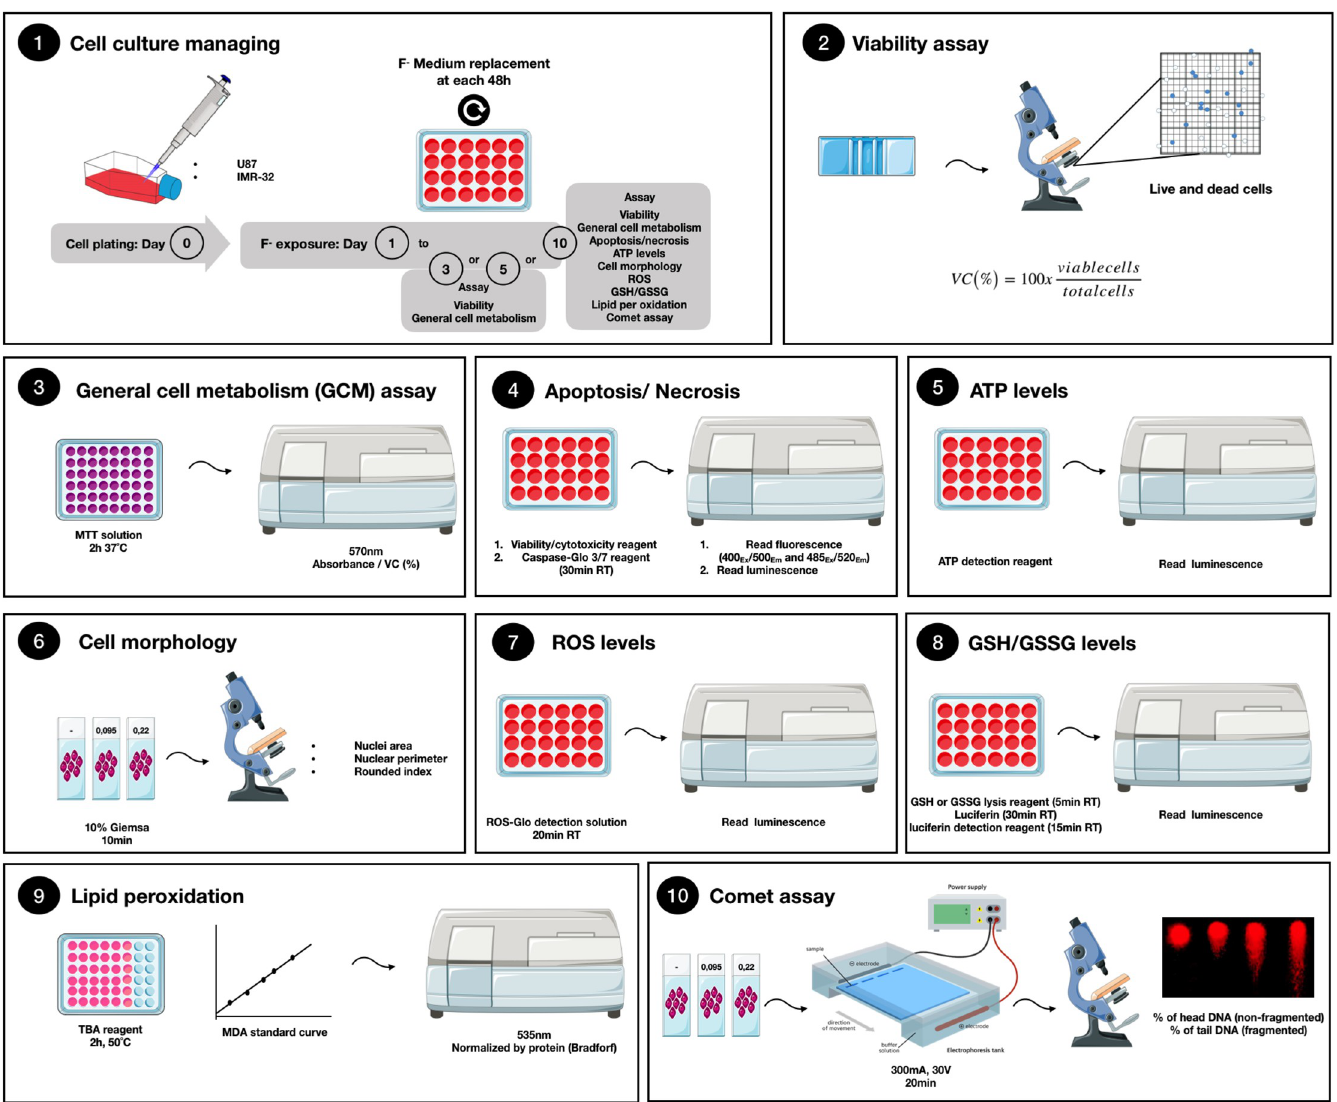
Fig 1. Methodological framework of cell culture and analyses. 1) U87 and IMR-32 cells were maintained in DMEM+10%FBS. Cells were exposed for 3, 5 or 10 days to a solution containing different F concentrations. After the exposure period, the following analyses were performed: 2) Viability assay; 3) General cell metabolism by MTT reduction; 4) Apoptosis/Necrosis; 5) ATP levels; 6) Cell morphology; 7) Oxidative Biochemistry assays by measuring Reactive oxygen species, 8) Oxidative Biochemistry assays by measuring GSH/GSSG ratio, 9) Oxidative Biochemistry assays by measuring Lipid Peroxidation; and 10) Comet assay.